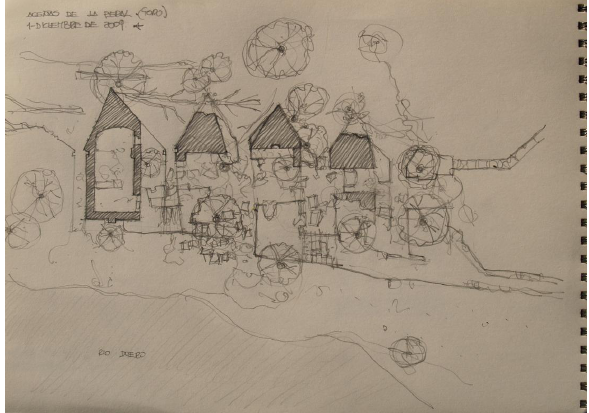
Figure 3: Hand sketch of almost unaccessible mill